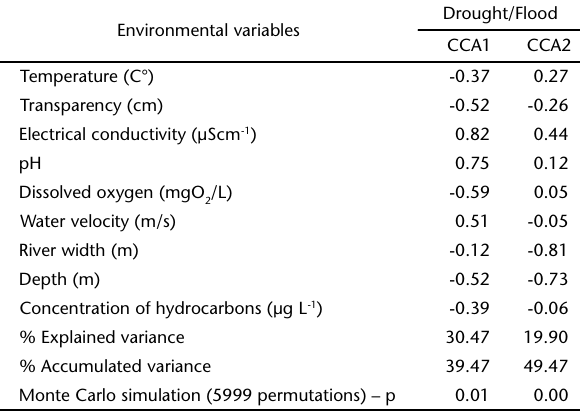
Table 2. Results of the Canonical Correlation Analysis for the occurrence of fish species and key environmental variables in periods of drought and flood in the Urucu River, Municipality of Coari, AM,